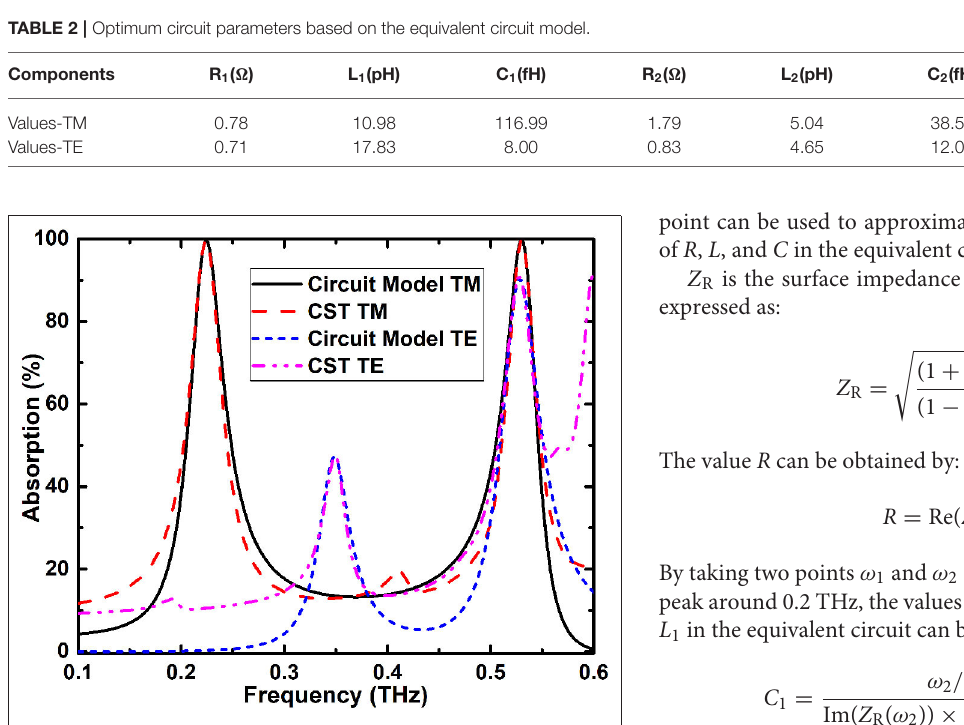
FIGURE 10 | Comparison of simulation results and equivalent circuit calculated results of the tunable dual-band absorber with TE and TM